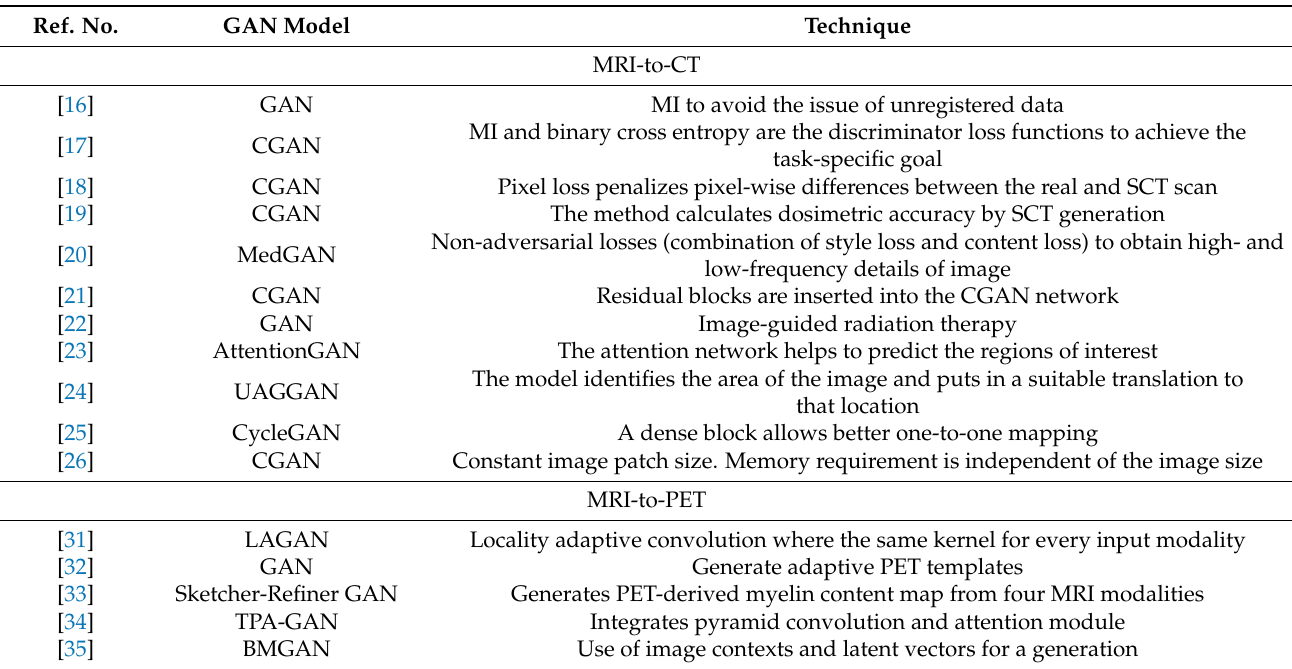
Table 5. Summary of GAN-synthesized images used for translation. Ref.